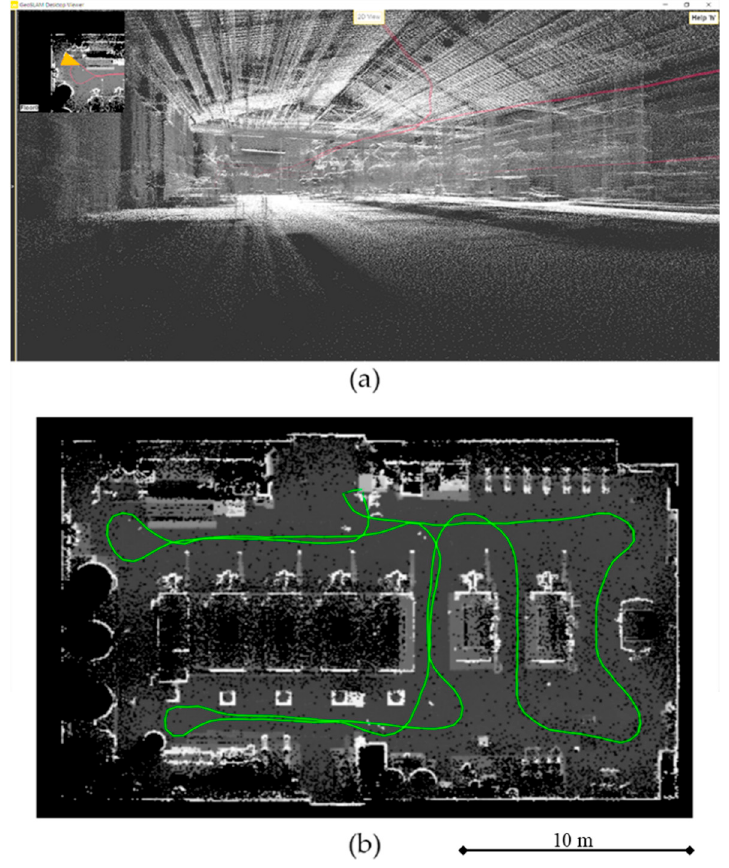
Figure 4. Three-dimensional scene shown by GeoSlam viewer ( a ) and followed trajectory during the data acquisition (green line) ( b ).